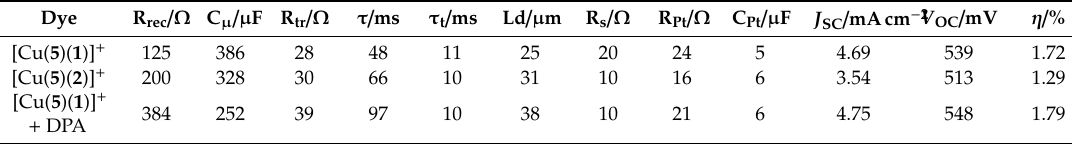
Figure 15. Nyquist plots of the DSCs containing dyes [Cu( 5 )( 1 )] + and [Cu( 5 )( 2 )] + , and [Cu( 5 )( 1 )] + with the co-adsorbent DPA. Solid lines represent fitted curves and the solid-circles represent experimental data. Table 4. EIS parameters 1 obtained from fitting the experimental data for DSCs with dyes [Cu( 5 )( 1 )] + and [Cu( 5 )( 2 )] + , and with [Cu( 5 )( 1 )] + with the co-adsorbent n -decylphosphonic acid (DPA). Data are for the most representative DSC of a set of four; data for all the DSCs are given in Table S1 (see Supporting